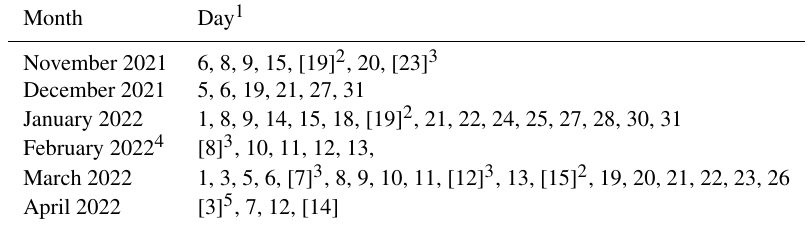
Table 7. List of Level 6 alert during 5 November 2021–12 April